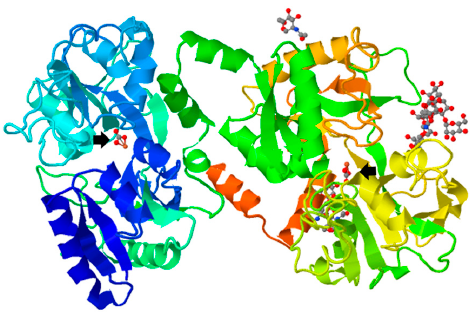
Figure 1. Tertiary structure of bovine ferric lactoferrin. Protein Data Bank (http://www.rcsb.org/pdb/explore.do?StructureId=1BLF). The bovine lactoferrin is represented in rainbow ribbon diagram showing two-lobe, four-domain polypeptide. Arrows show ferric ions.